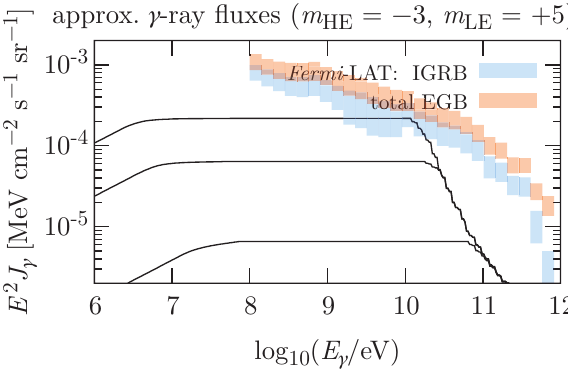
Figure 7. Fluxes at Earth of gamma-ray cascades produced in UHECR propagation for m HE = − 3 and m LE = 5 when assuming z max = 1, 3 and 5, compared to Fermi -LAT measurements from Ref.